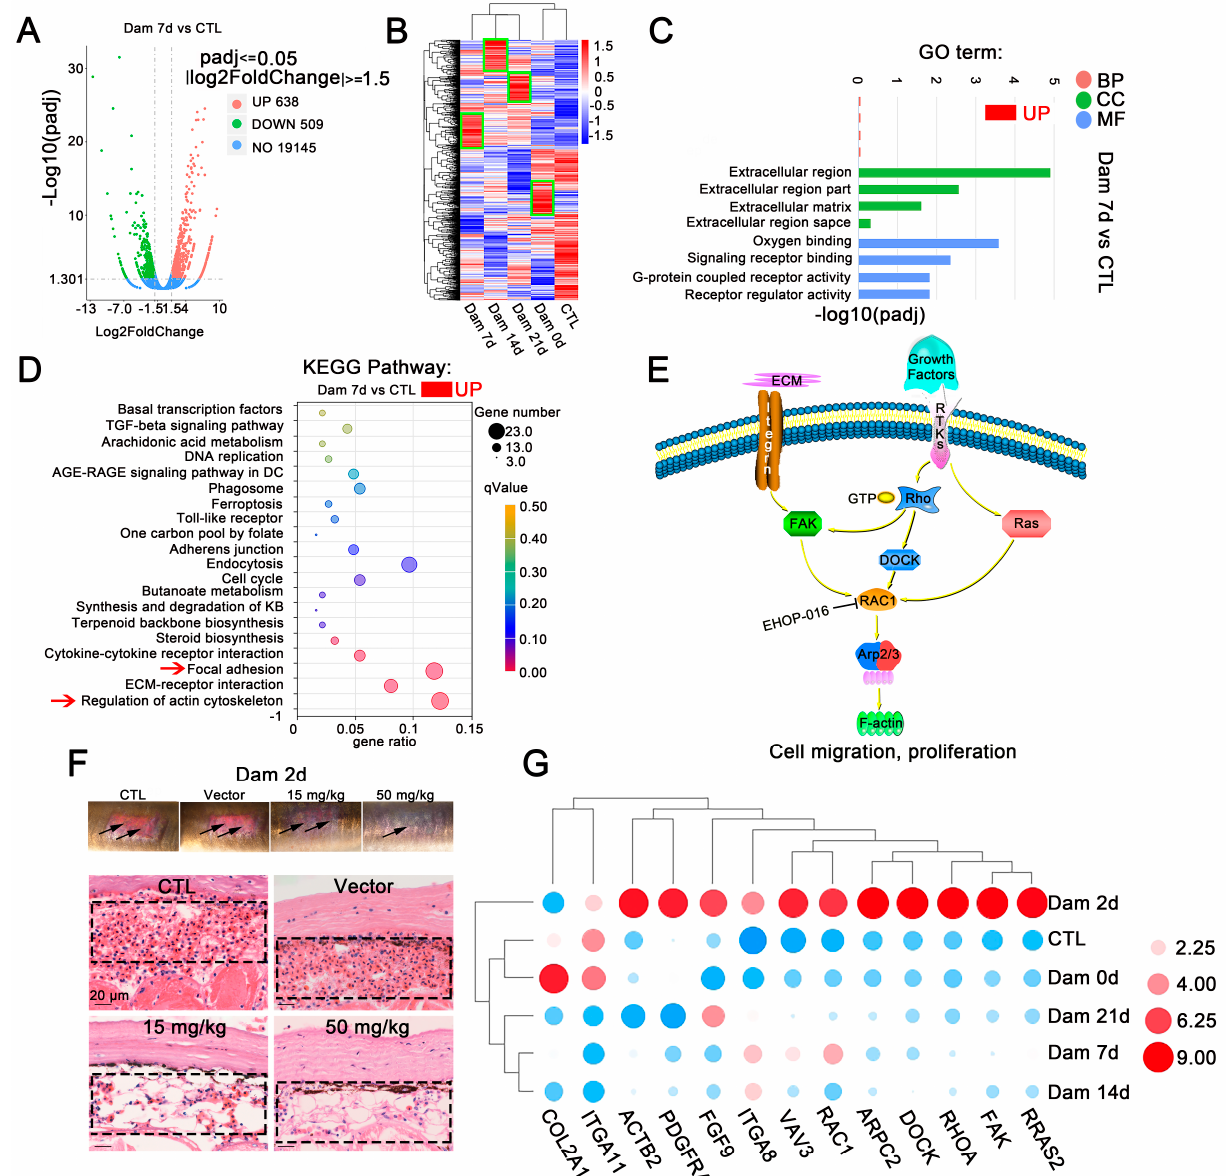
Figure 3. RNA-seq results of lamprey epidermis and dermis tissue after skin damage. ( A ) Volcano plot of the differentially expressed genes (DEGs) after skin damage in lampreys. ( B ) In the cluster expression analysis, the DEGs changed at different time points (green box). ( C ) GO functional category analysis. ( D ) KEGG pathway classification analysis and the DEGs involved in the main pathway; the red arrow indicates major signaling pathways. ( E ) The main DEGs eventually induced high expression of F-actin, changed the cytoskeleton, responded to mechanical injury and induced cell migration. ( F ) Early effect of the addition of the Ehop-016 inhibitor. Scale bars, 20 μ m. ( G ) Thirteen genes related to regulation of the actin cytoskeleton and focal adhesion kinase were associated with significant changes in two signaling pathways related to focal adhesion kinase. DC: diabetic complication; KB: ketone bodies.